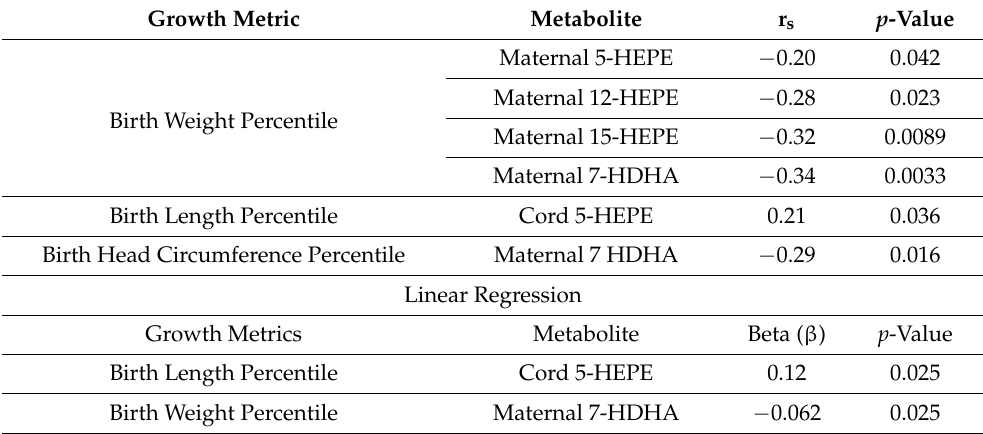
Table 10. Significant relationships between omega-3 plasma metabolite levels and infant growth